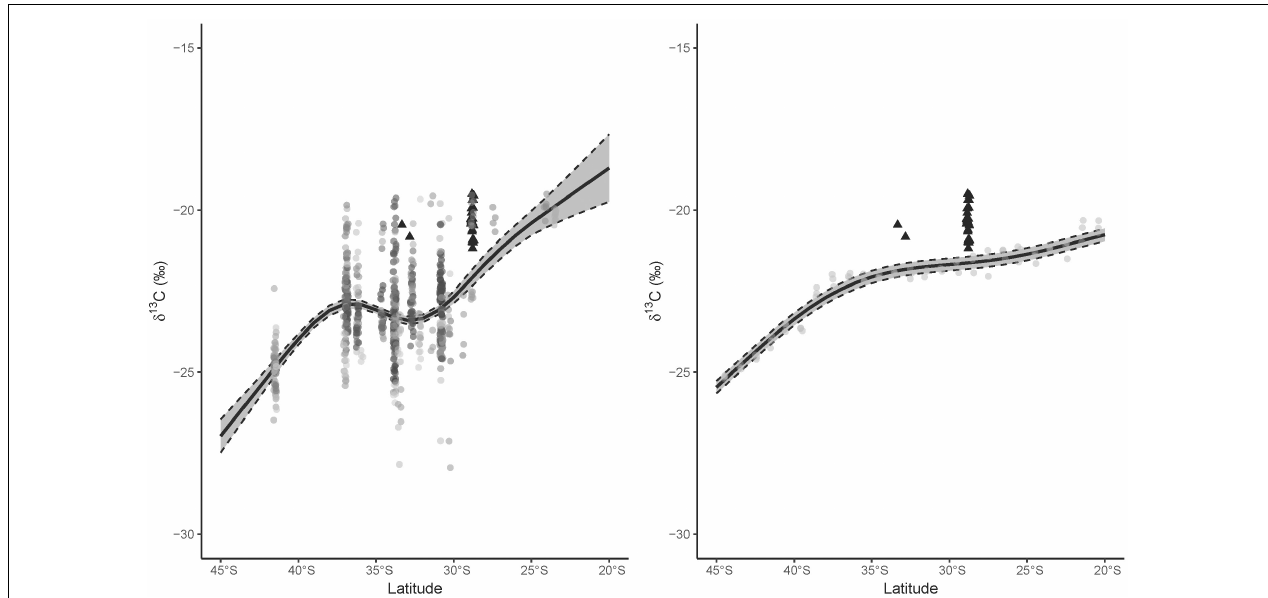
FIGURE 2 | Relationship between latitude and δ 13 C values calculated from (left) trophic enrichment-adjusted values of fishes and cephalopods (only mean individual values displayed, species in colors) collected along the east coast of Australia (black dashed lines indicate 95% confidence interval around the model), and (right) the comparable range of yearly mean coastal δ 13 C plk values from the NEMO-MEDUSA data. Different species used to calculate the relationship indicated in different colored circles, and great hammerhead shark ( Sphyrna mokarran ) mean individual trophic enrichment-adjusted values are indicated in black triangles along with their associated latitude at